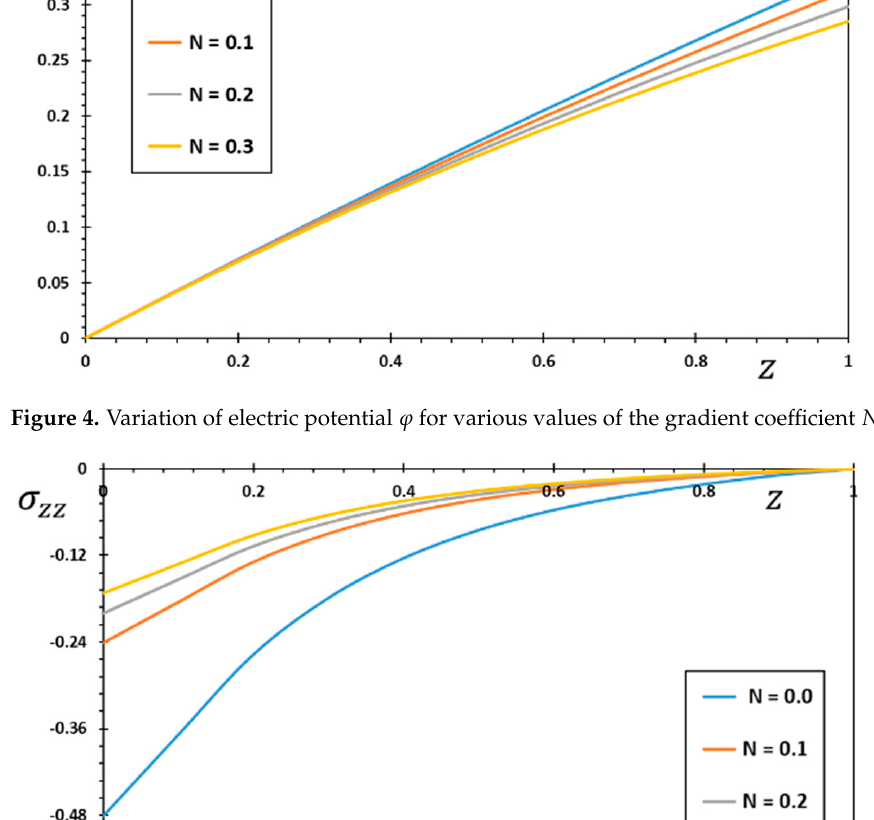
Figure 3. Variation of temperature 𝜃 for various values of the gradient coefficient 𝑁 .